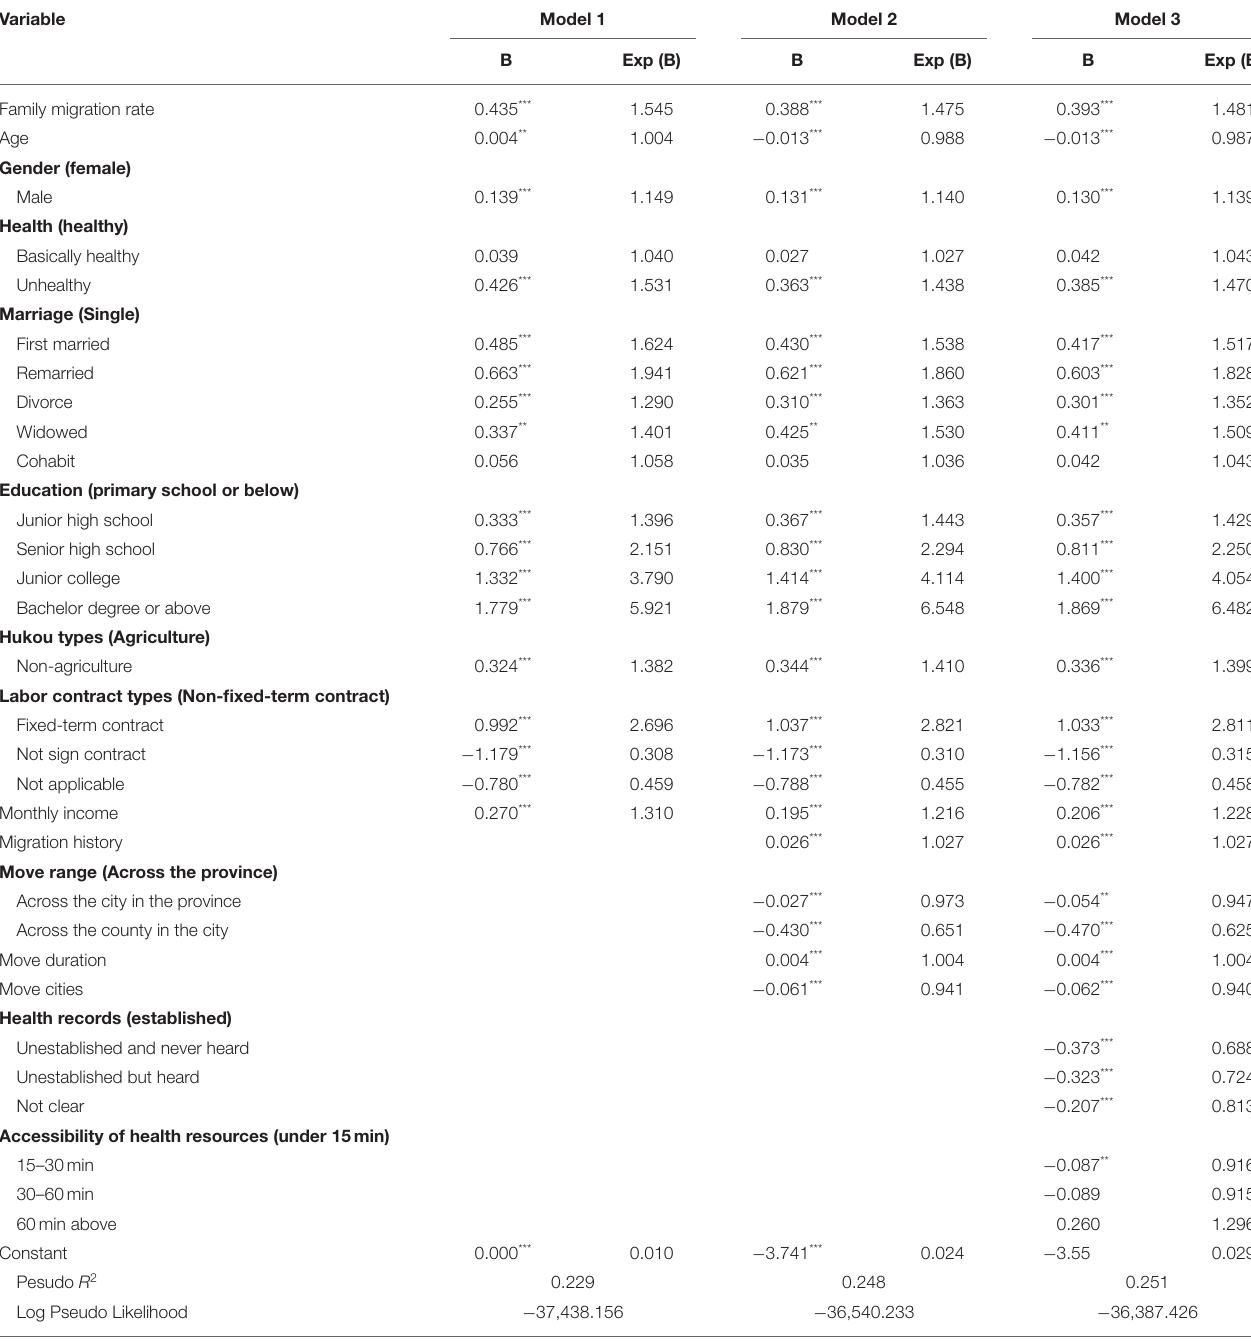
TABLE 6 | Logistic regression results of family migration rate on access to health insurance of floating population in China ( N =